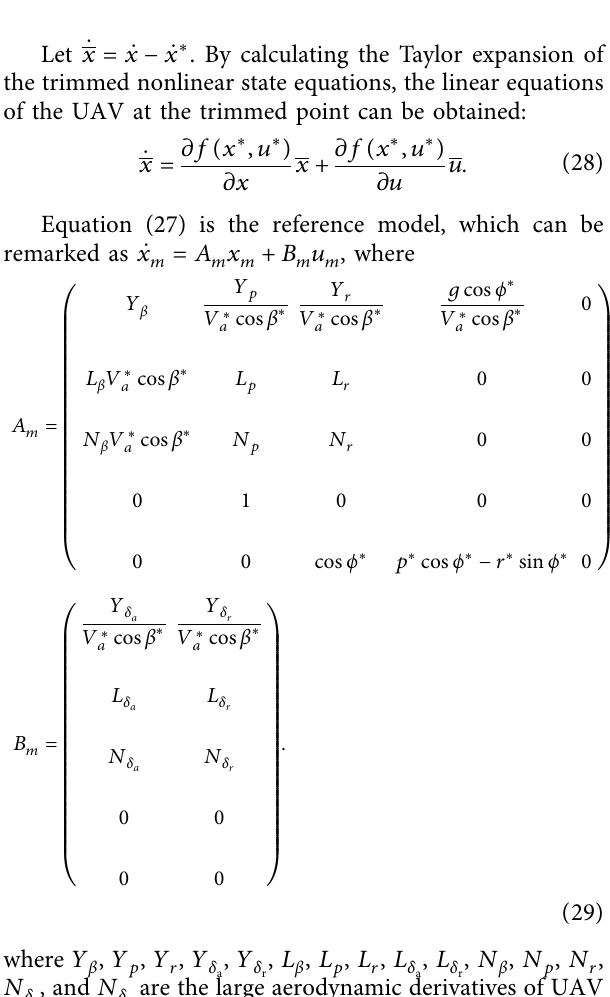
Figure 6: Reference model varying